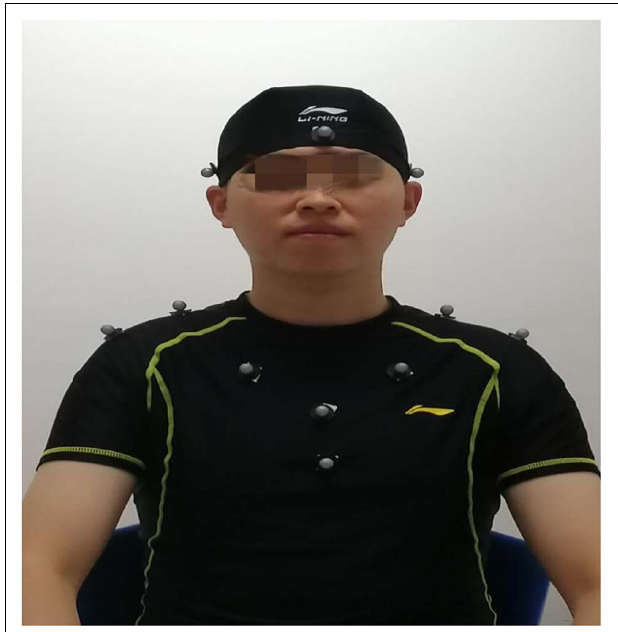
FIGURE 1 | Position of marker points on the volunteers.